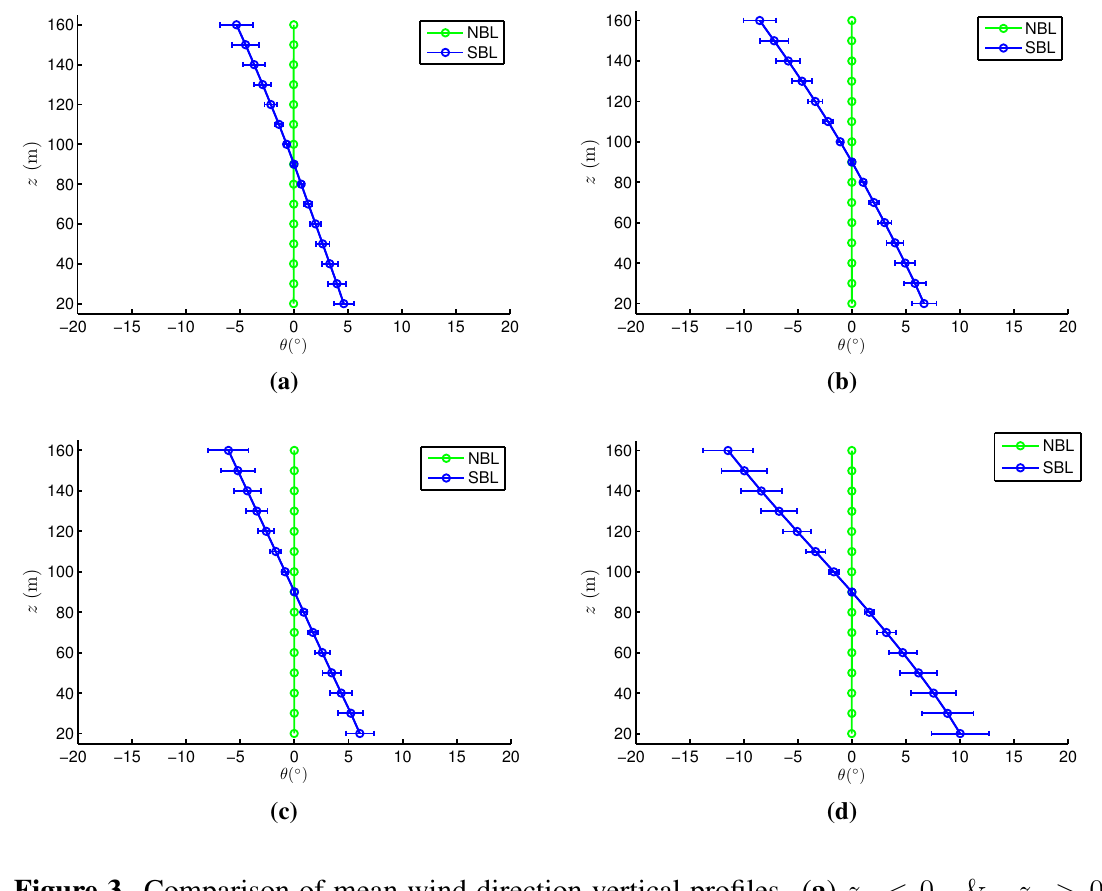
Figure 3. Comparison of mean wind direction vertical profiles. ( a ) z